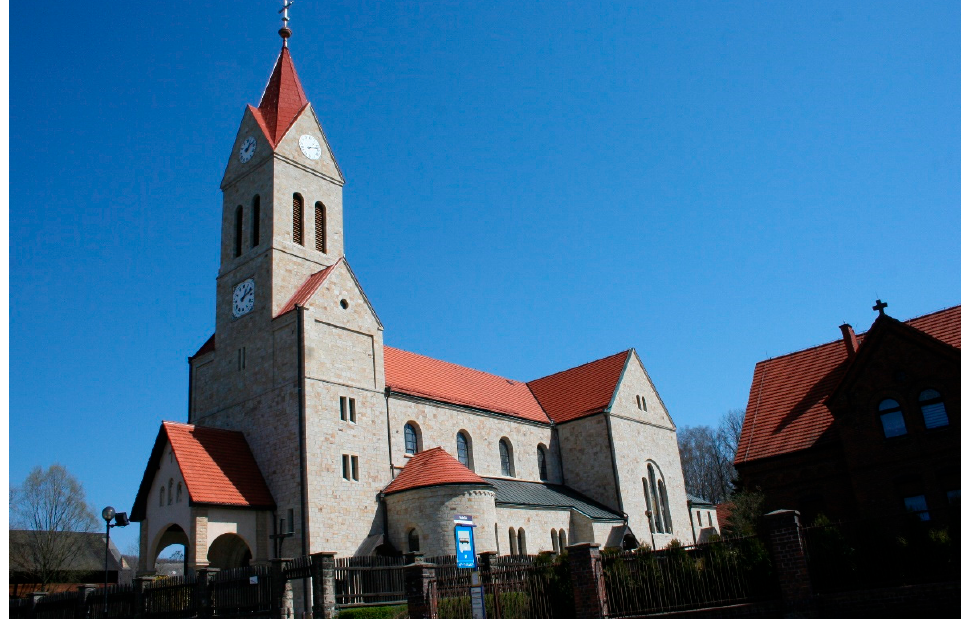
Figure 7. Orzesze (Ger. Orzesche), Church of the Visitation of the Blessed Virgin Mary designed by Teofil Wygasz, 1926–1930. Created by author.